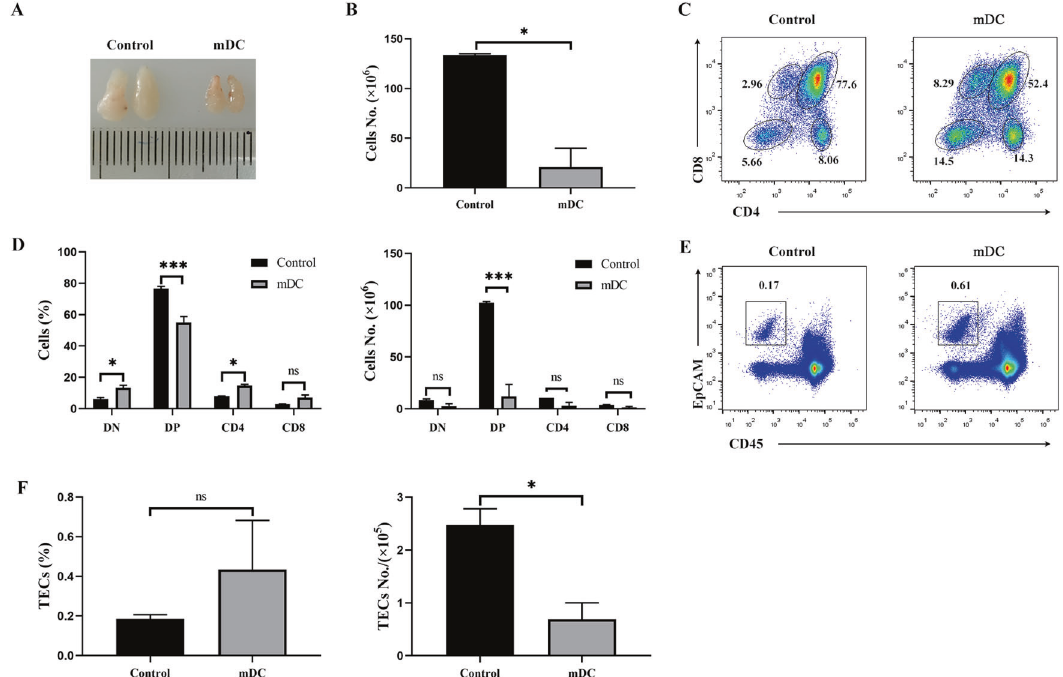
Fig. 5 Intrathymic injection of mature DCs led to acute thymic atrophy. For A to F : Thymic atrophy following the intrathymic injection of mDCs ( n = 3). The same volume of PBS was used as a control ( n = 3). A Thymus morphology and size. B Total numbers of thymocytes were calculated. C Thymocytes were stained with PE-conjugated anti-CD4 and APC-labeled anti-CD8 antibodies. The thymocyte subpopulations were examined by FCM. D The percentages and absolute numbers of indicated thymocyte subpopulations were calculated. E The cells isolated from the thymus of recipient mice were stained with Alexa Fluor 488-conjugated anti-CD45 and APC-labeled anti-EpCAM antibodies, respectively. CD45 - EpCAM + TECs were detected by FCM. F The percentages and absolute numbers of CD45 - EpCAM + TECs were calculated. All data are from three independent experiments. Representative fi gures of these three experiments are shown. Data are expressed as the mean ± SD. * P < 0.05, *** P < 0.001 compared with the control